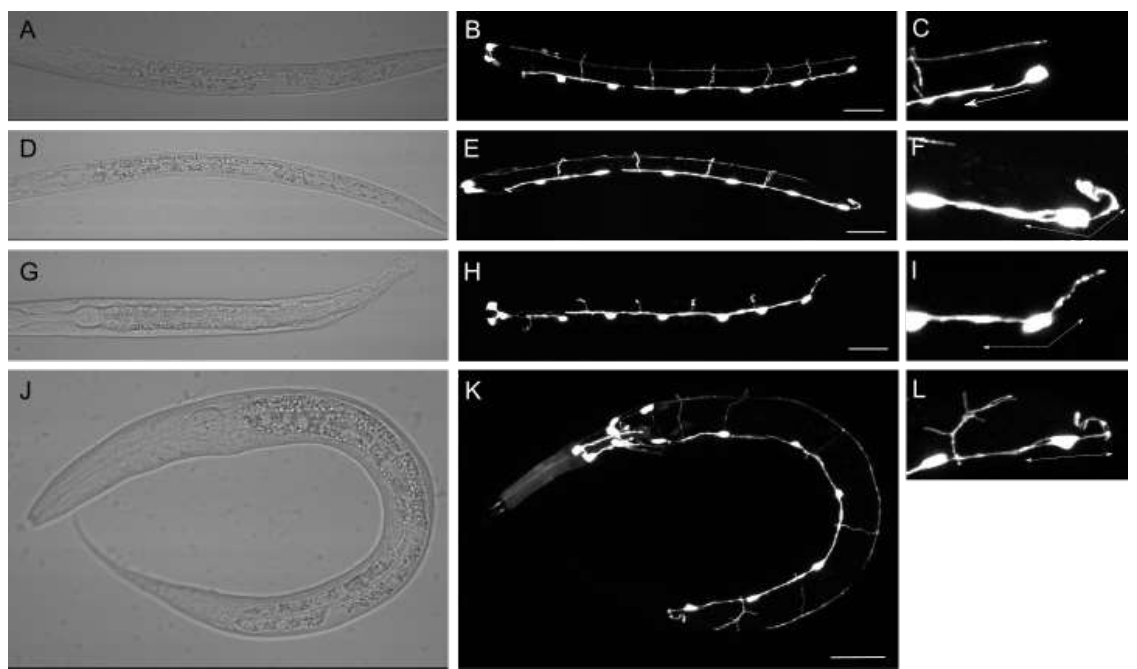
Figure 4. mig-5 and syg-2 L1s have bipolar Pdns. ( A – C ) Wild-type animals have 6 DD neurons (arrowheads). ( C ) DD6 extends its axon in the anterior direction (arrow). ( D – F ) syg-2(lh6) animals with Pdns have DD6 neurons with two processes. F) DD6 extends one axon anteriorly and one dorsally (arrows). ( G – I ) A mig-5(rh94) L1 exhibits a bipolar DD6. ( J – L ) A mig-5; syg-2 double-mutant L1. The DD6 processes extend anteriorly and posteriorly. Note that the anterior commissure forms multiple branches. Scale bars are 20 µ